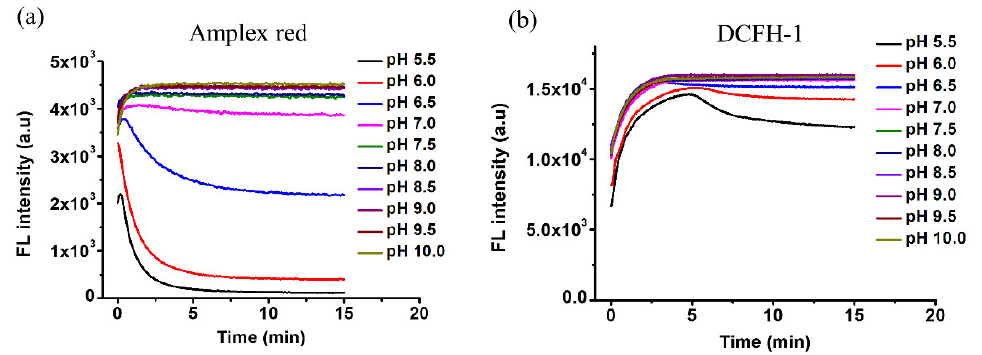
Figure 3. ( a ) The response kinetic curves of Amplex red upon reaction with HRP/H 2 O 2 under different pH conditions, where the final concentrations in the reaction mixture of the Amplex red, HRP, and H 2 O 2 were set at 50 μM, 10 nM, and 10 mM, respectively. ( b ) pH effects on the detection by DCFH-1 , where the concentrations of DCFH-1 , HRP, and H 2 O 2 were set at 50 μM, 50 nM, and 10 mM, respectively. The 1× PBS (10 mM) solutions were adjusted by 2 M NaOH and/or 2 M HCl to make the solutions with various pHs.